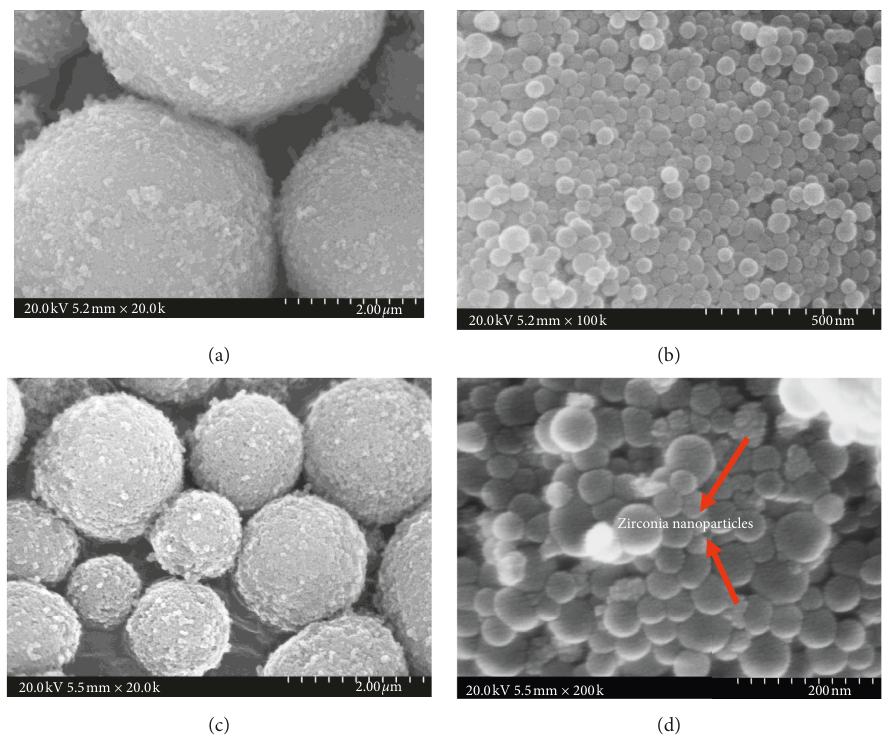
Figure 6: SEM micrographs of (a) silica nanoparticle nanoclusters, (b) surface of silica nanoclusters, (c) silica-zirconia nanoclusters, and (d) surface of silica-zirconia